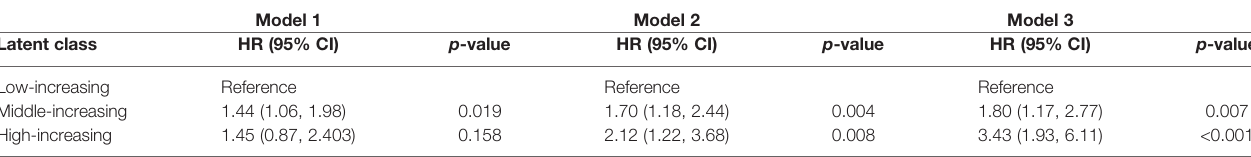
TABLE 4 | Cox regression results of incidence of DKD for the latent class of serum